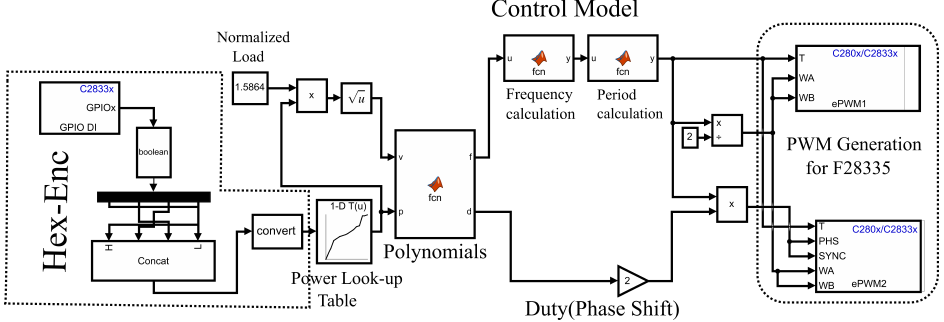
Figure 13. PWM generation model in